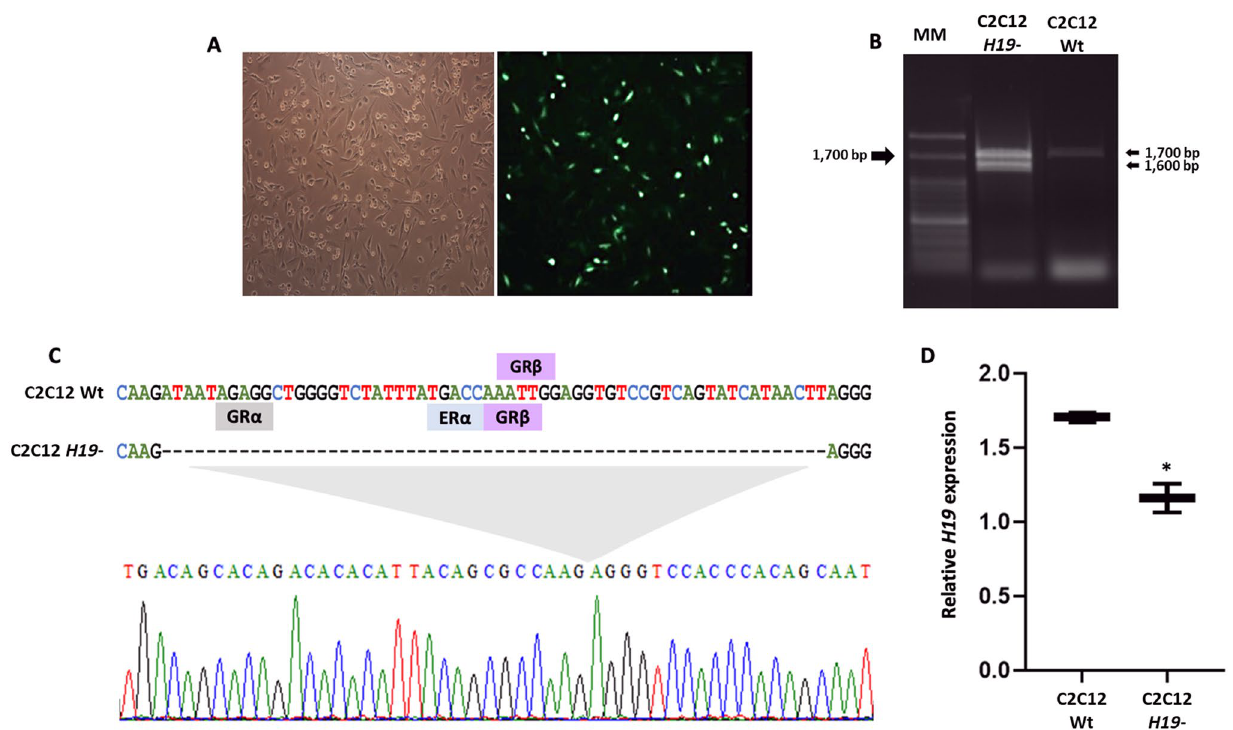
Figure 2. CRISPR/Cas9 screening and molecular characterization. ( A ) Transfection confirmation by GFP detection in C2C12 myoblast cells (100X magnification). ( B ) Amplification of the promoter region of C2C12 Wt and C2C12 H19 - after CRISPR-Cas9 edition (1686 bp). MM, Molecular Marker (100 bp). ( C ) Alignment between H19 reference and C2C12 H19- colony sequence. The chromatogram shows the location of